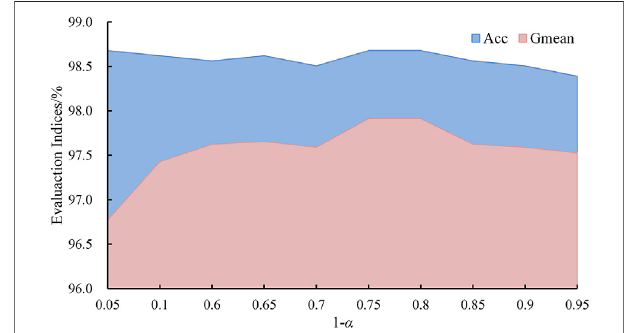
FIGURE7| Evaluationperformanceofthemodelindifferent(1- α )values.